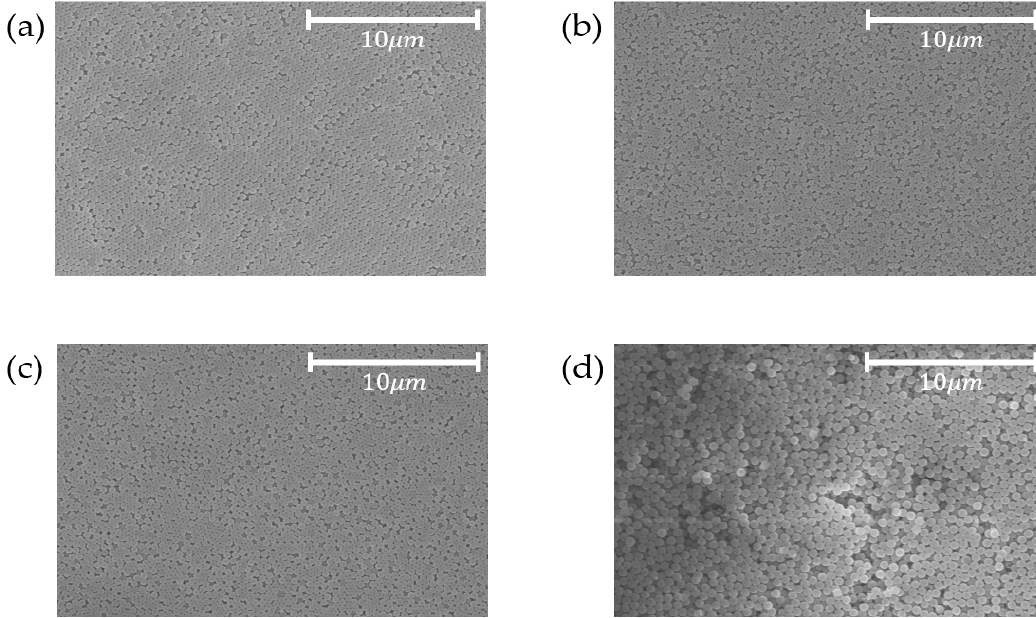
Figure 7. SEM photographs of the silica solution coatings: ( a ) No added phenol-formaldehyde resin (Case 1); ( b ) 0.027 g of added phenol-formaldehyde resin (Case 2); ( c ) 0.030 g of added phenol-formaldehyde resin (Case 3); ( d ) 0.033 g of added phenol-formaldehyde resin (Case 4).